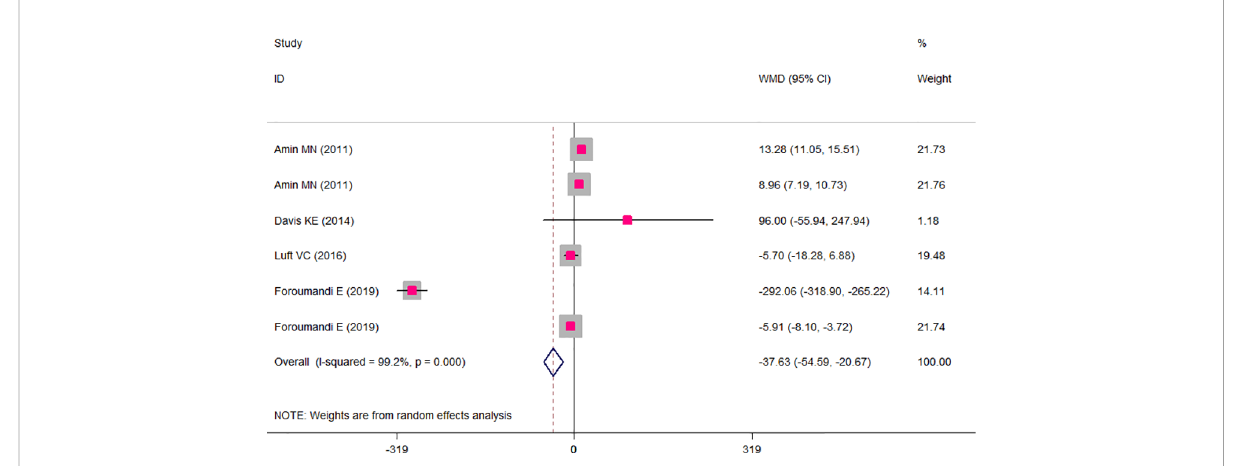
FIGURE 4 Weighted mean difference (WMD) with 95% con fi dence interval (CI) of mean circulating advanced glycation end products (AGEs) in obese versus non-obese individuals. I 2 represents the degree of heterogeneity.